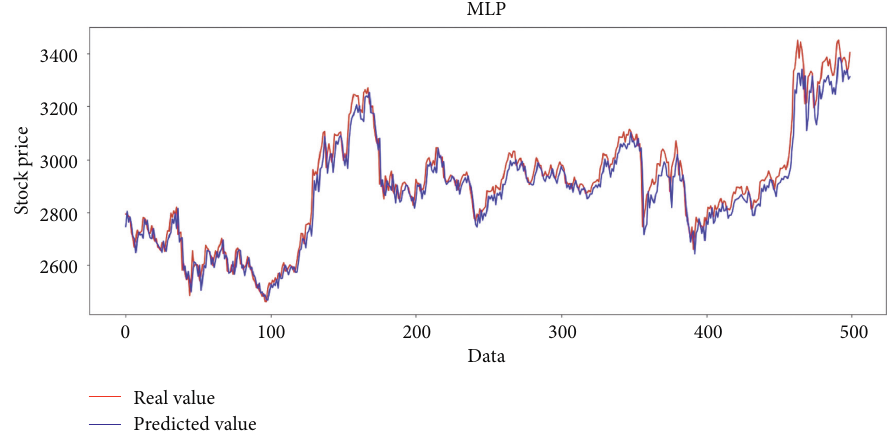
Figure 5: Comparison of the predicted value and the real value for MLP.